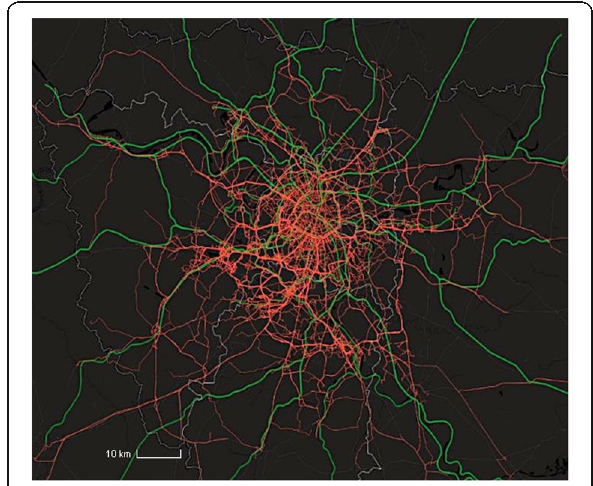
Fig. 1 Map of the trips proposed by Karos (in red) and the rail network (in green) in Ile-de-France in 2016 – 2017©